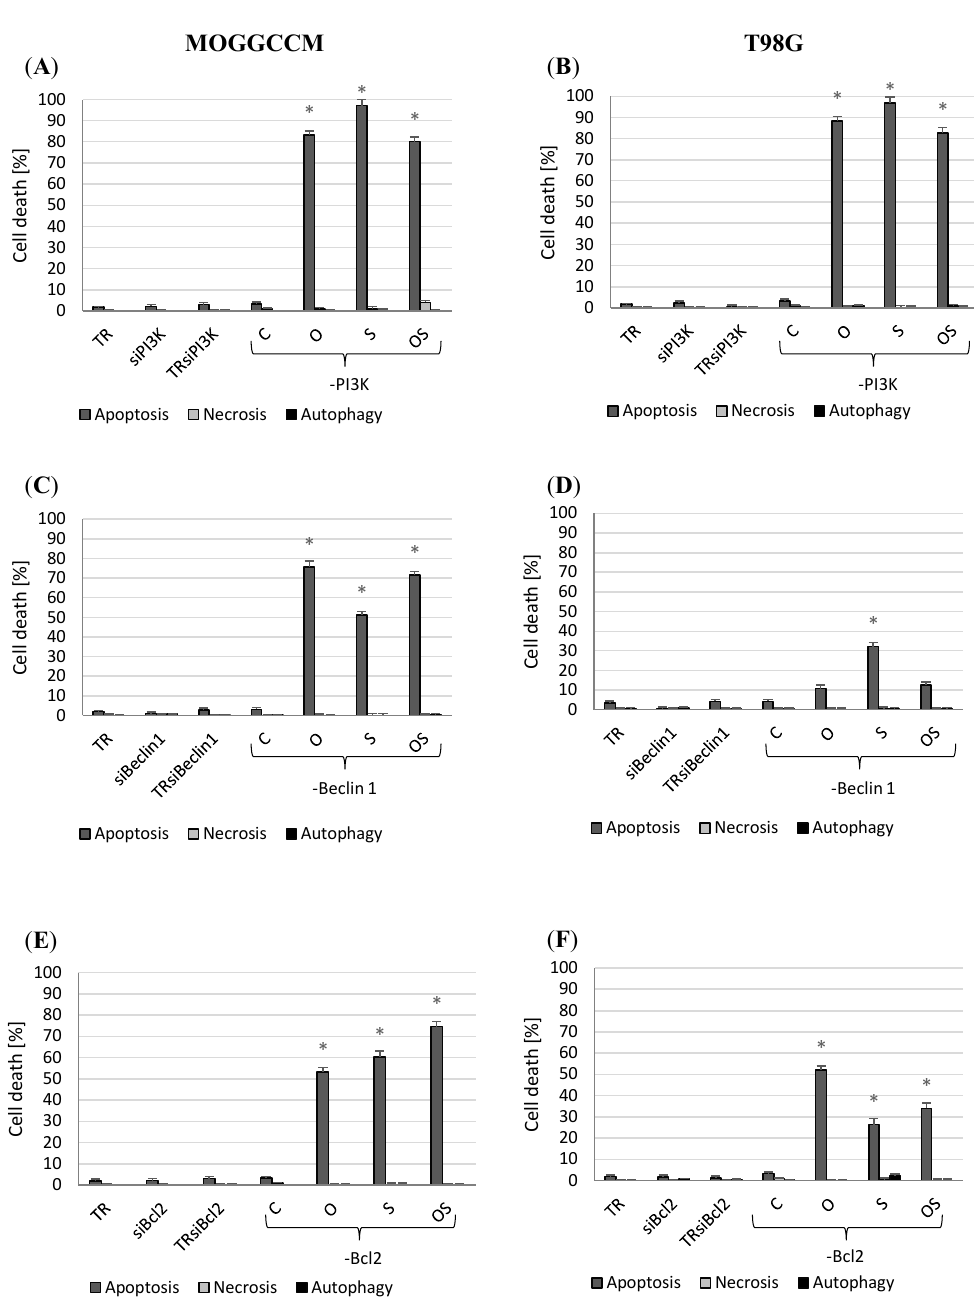
Figure 5. Level of apoptosis, autophagy, and necrosis in the MOGGCCM ( A , C , E ) and T98G ( B , D , F ) cells with inhibited PI3K ( A , B ), Beclin 1 ( C , D ), and Bcl-2 (B-cell lymphoma 2) ( E , F ) expression by specific siRNA (small interfering RNA) upon the osthole and sorafenib treatment. C—control, O—osthole, S—sorafenib; * p < 0.05 .